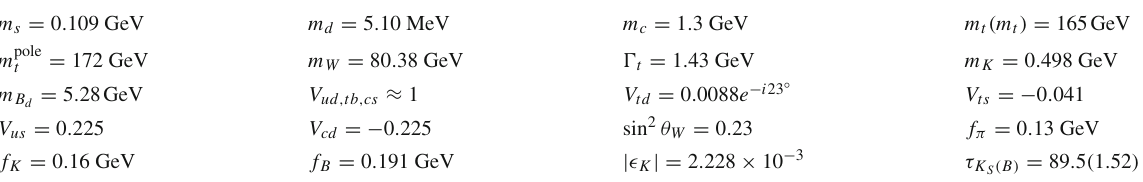
Table 1 Inputs for the numerical estimates